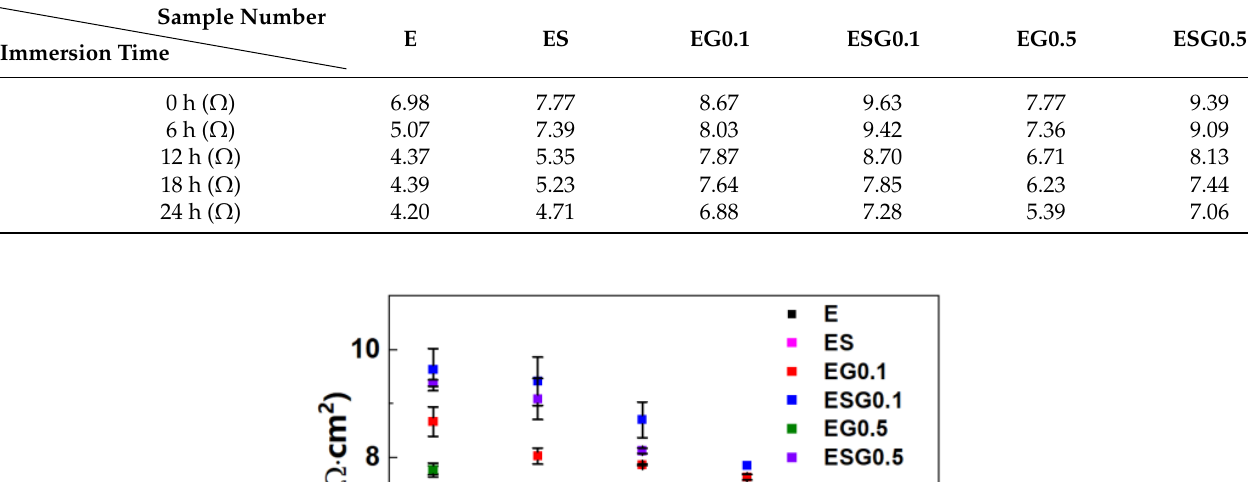
Table 5. Impedance modulus of graphene-modified epoxy resin at 0.1 Hz frequency with different immersion times.